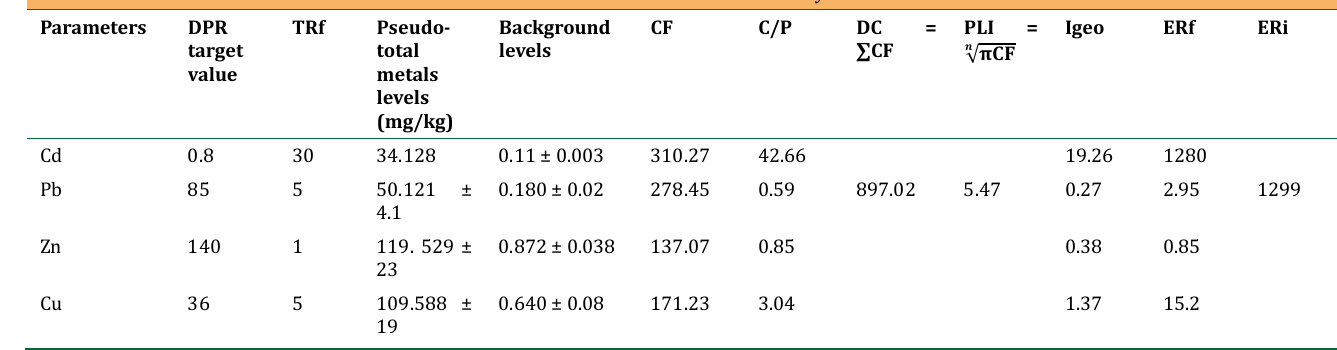
Table 10: Contamination status of heavy